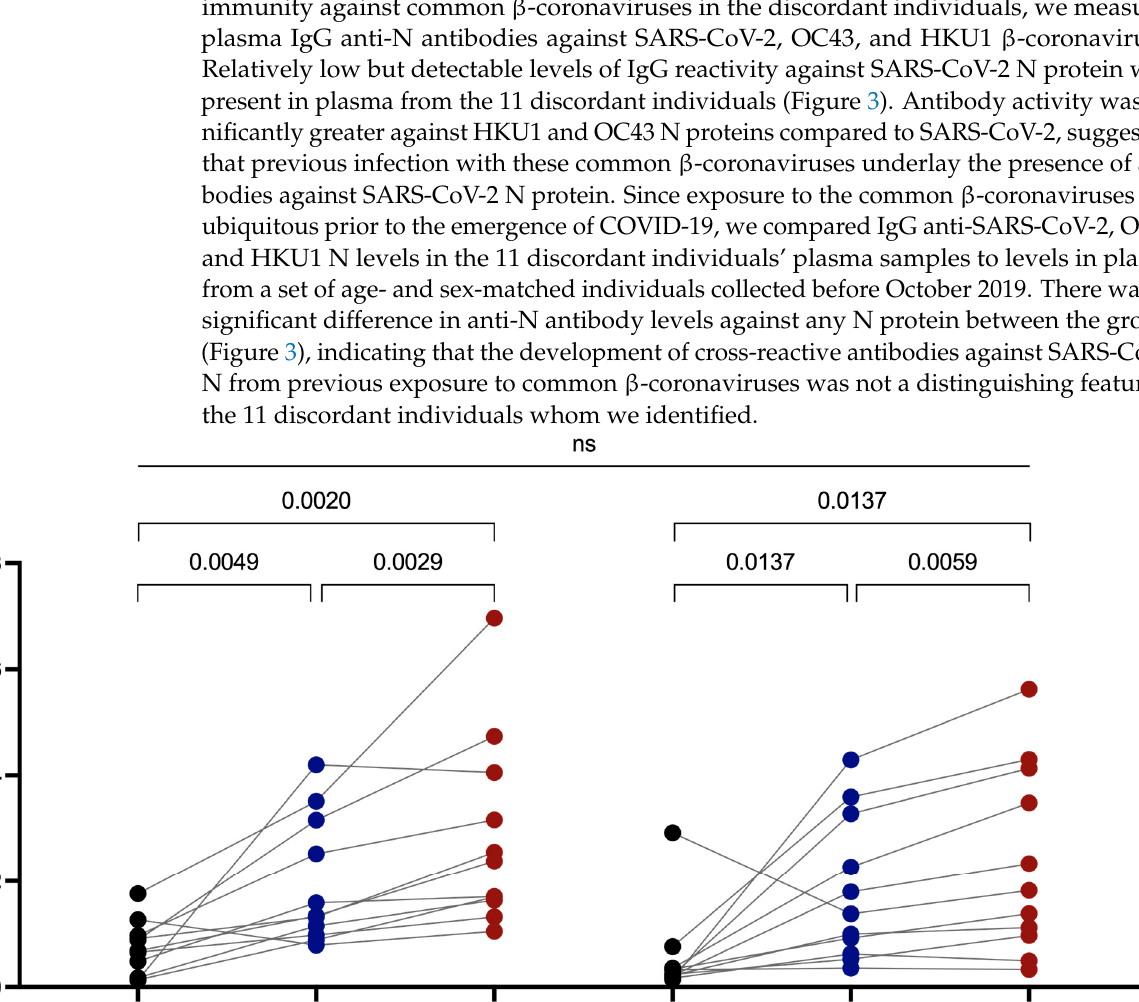
8 of 15 Figure 2. Assessment of potential for innate protection against SARS-CoV-2 infection measured by ELISA. ( a ) The ability of plasma from discordant subjects to inhibit the SARS-CoV-2 S interaction with ACE2 was tested with plasma from previously infected subjects included as positive controls. ( b ) Circulating IFN- α levels in plasma from discordant subjects and age- and sex-matched previ-